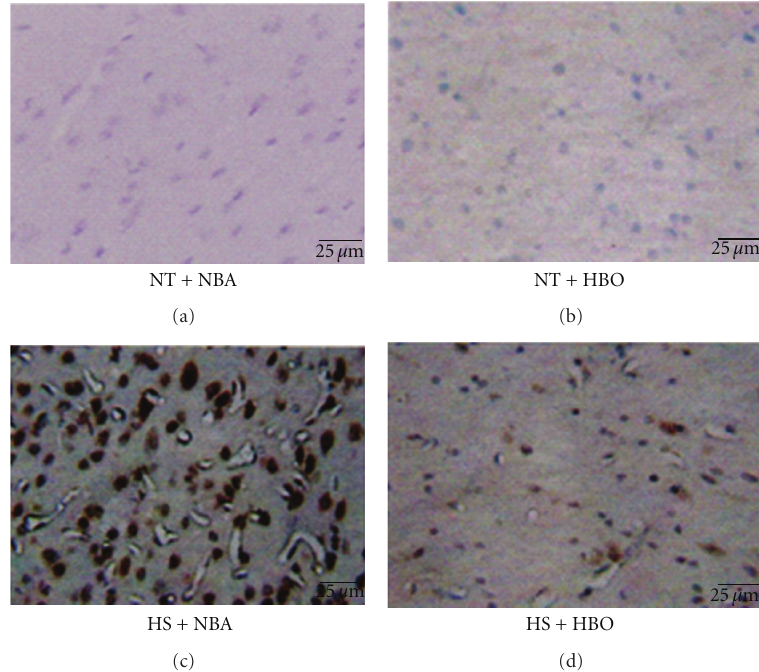
Figure 5: Photomicrographs of inducible nitric oxide synthase (iNOS) staining of the hypothalamus of normothermic (NT) mouse received normobaric air (NBA) (NT+NBA), NT mouse received hyperbaric oxygen (HBO) (NT+HBO), heatstroke (HS) mouse received NBA (HS+NBA), or HS mouse received HBO (HS+HBO). The animals were killed at 4 hours after the termination of 1-hour heat exposure or the equivalent time for the normothermic